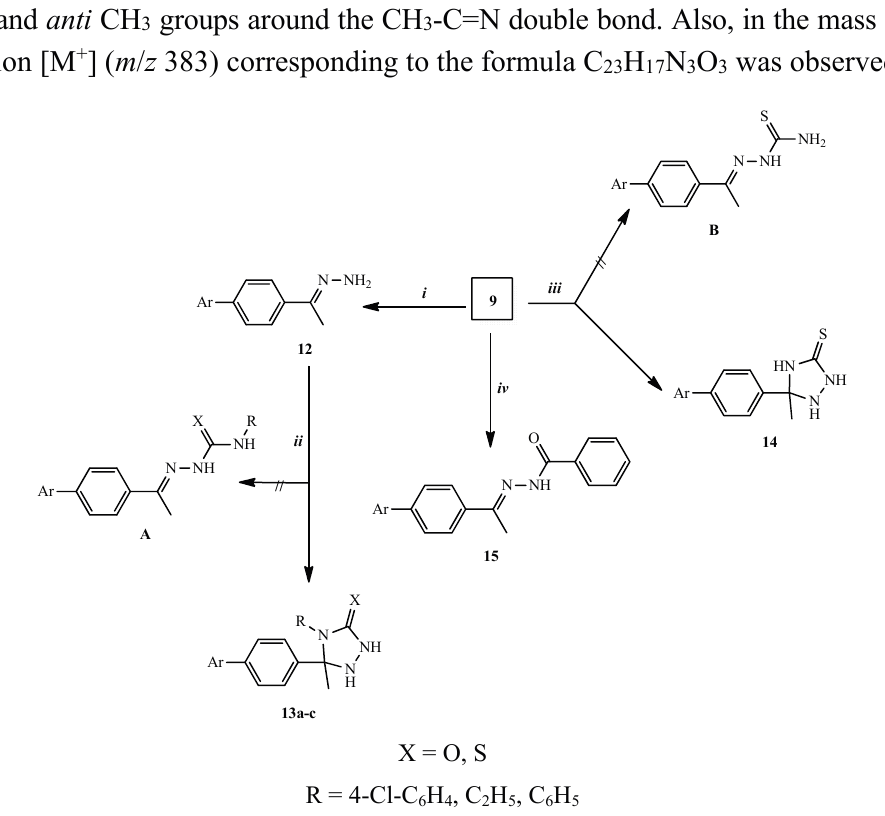
Scheme 2. Synthesis of triazole derivatives 13a – c , 14 and compound 15 . Reagents